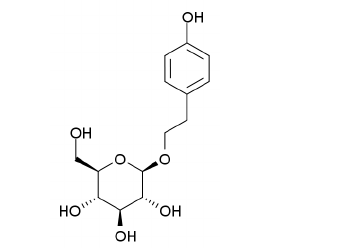
Figure 1. Chemical structure of salidroside (SAL), CAS number: 10338-51-9.